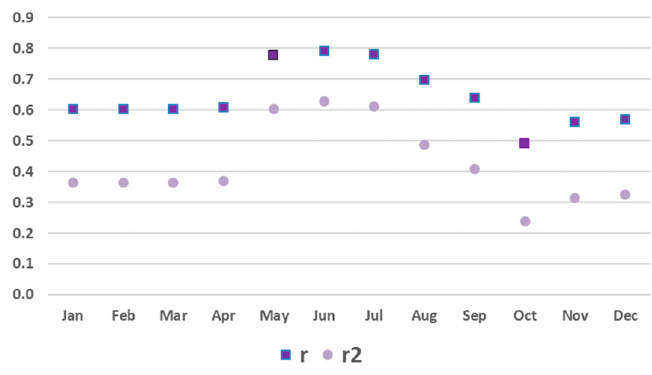
Figure 8. Monthly correlation coe ffi cients (r) and coe ffi cients of determination (r 2 Figure 8 . Monthly correlation coefficients (r) and coefficients of determination (r 2 ).